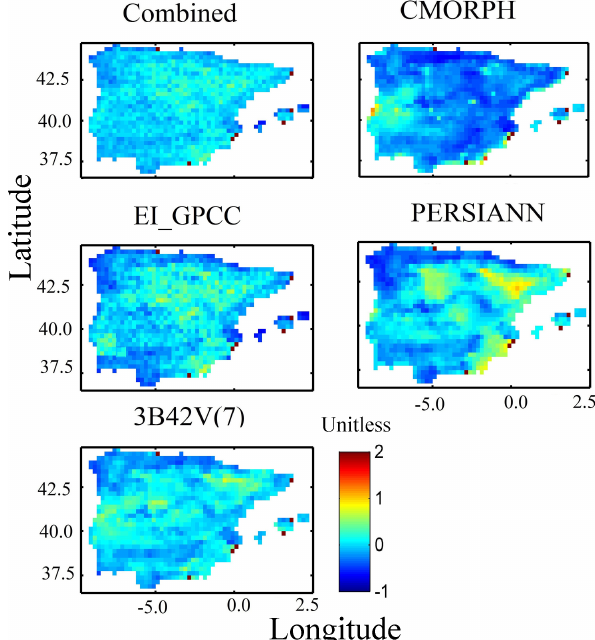
Figure 2. Map of the annual average relative difference (with re- spect to SAFRAN) for the different precipitation forcing